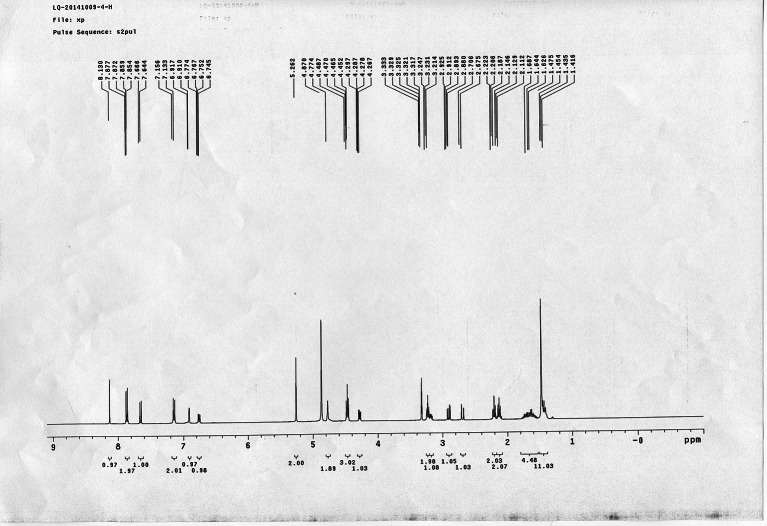
1H NMR spectra of compound 15.